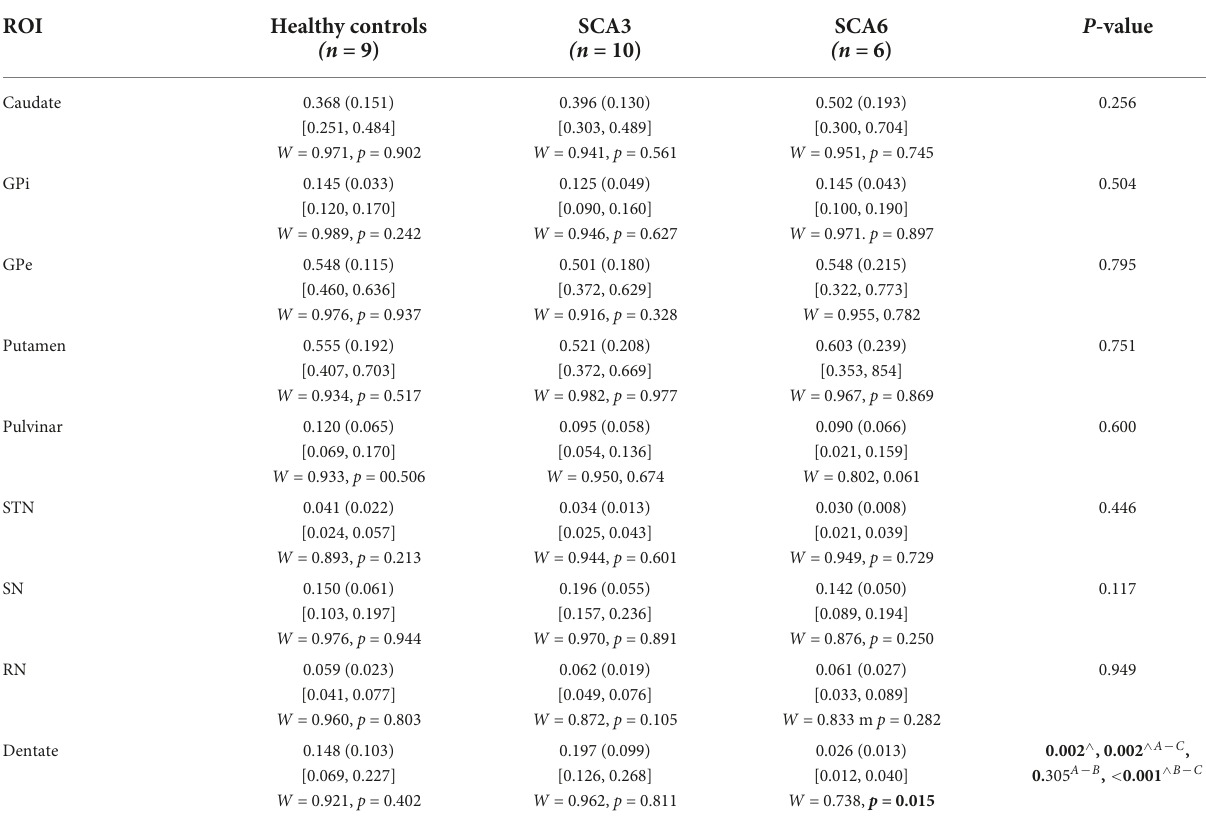
TABLE 4 Normalized susceptibility mass (in the unit of 10 3 ppm × mm 3 ) for ROIs compared across groups. Normalized susceptibility mass